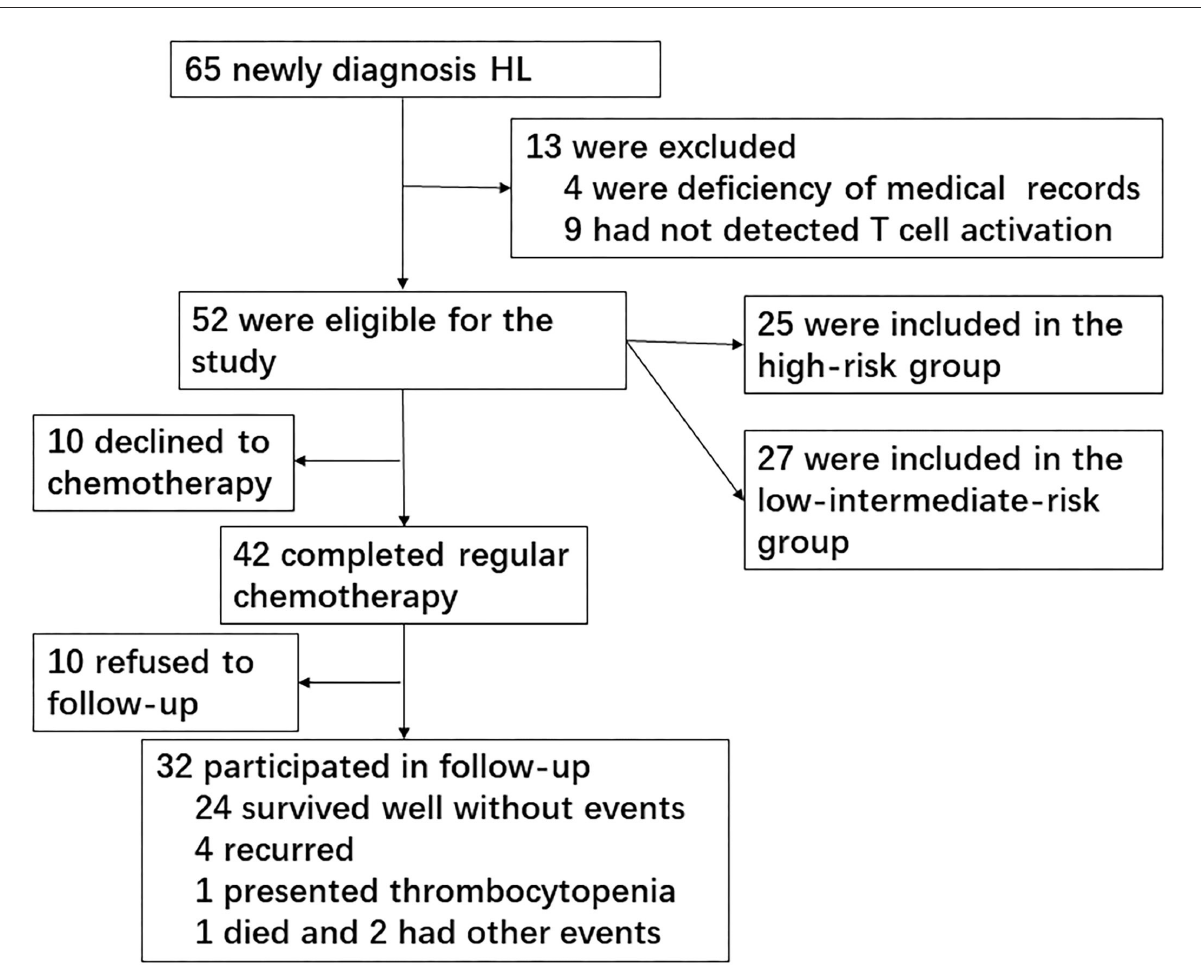
FIGURE1 Flowchart screening